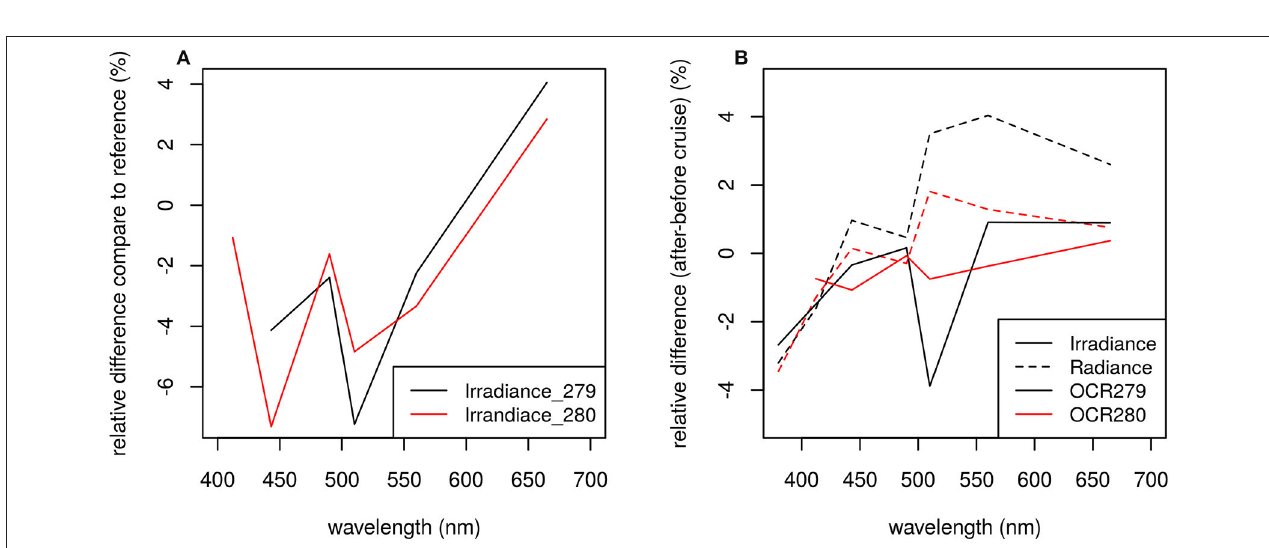
FIGURE 9 | (A) Relative difference of irradiance from OCR SN 279 and 280 used on lovapm006d float with respect to a reference sensor (bucket inter-comparison). (B) Relative difference of calibration coefficients determined at the LOV calibration laboratory before and after deployment.